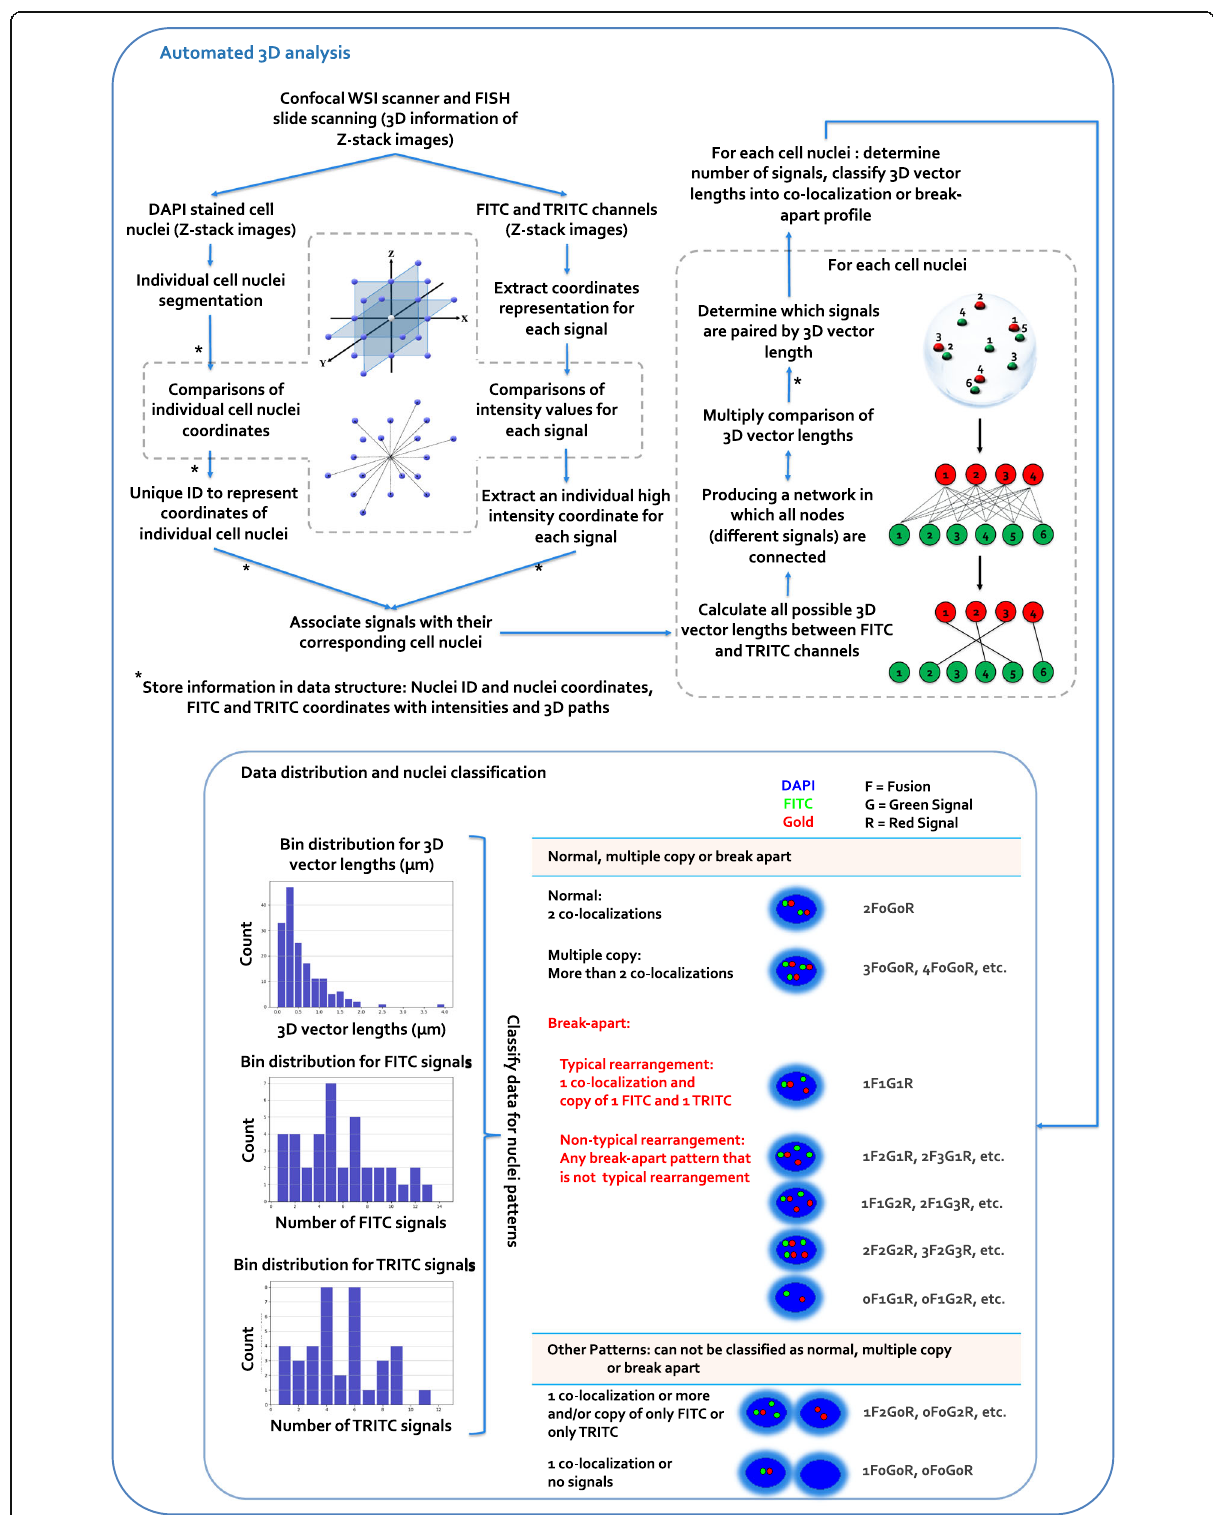
Fig. 2 Algorithm description for 3D scoring of FISH using confocal WSI scanner. Steps are described for 3D calculations for clear individual cell nuclei segmentation, gene signals detection and distribution of break-apart probes signal patterns, including standard break-apart, and variant patterns due to truncation, and deletion,